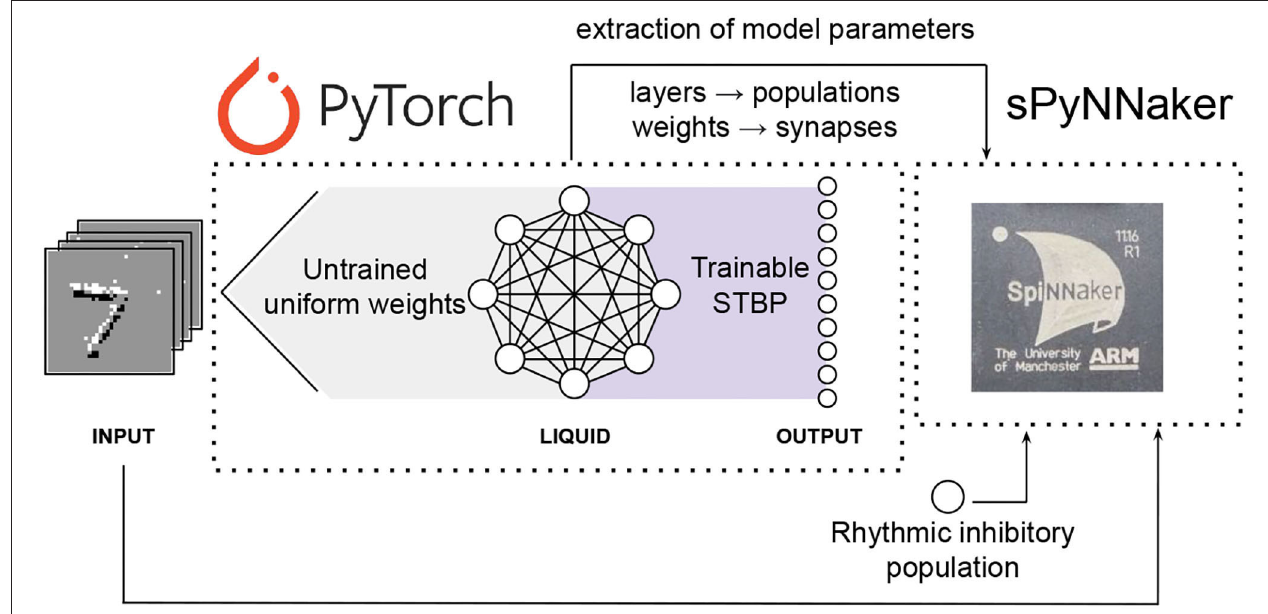
FIGURE 3 | Scheme of the different stages of the neuromorphic LSM classification system proposed in this work. The LSM model is defined in PyTorch, and the output layer is trained using STBP. The trained model parameters are used on an equivalent LSM model defined in sPyNNaker, a PyNN-based API for the SpiNNaker neuromorphic platform. A rhythmic inhibitory population is added to the sPyNNaker model to avoid undesired mixing of responses caused by reverberating activity while performing inference in real time.